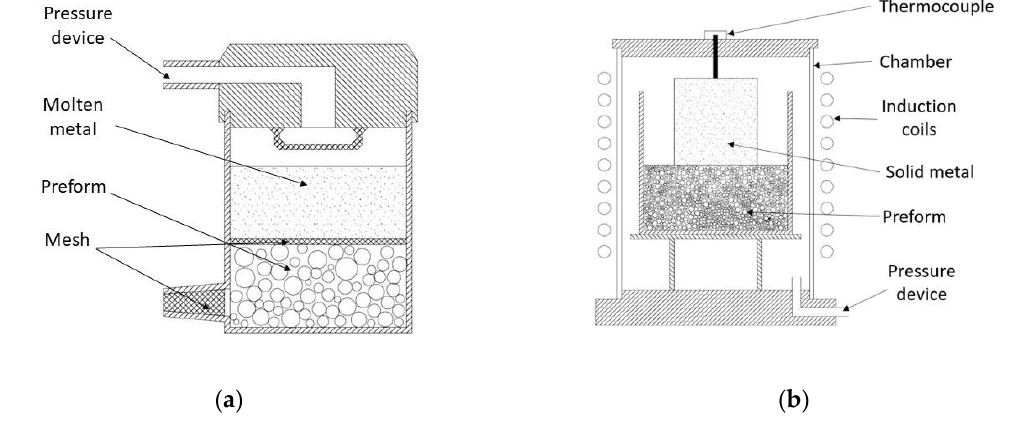
Figure 5. ( a ) Schematic of experimental DIG set-up adapted from Szlancsik et al. [56]; ( b ) DIG set-up adapted from Palmer et al. [60].